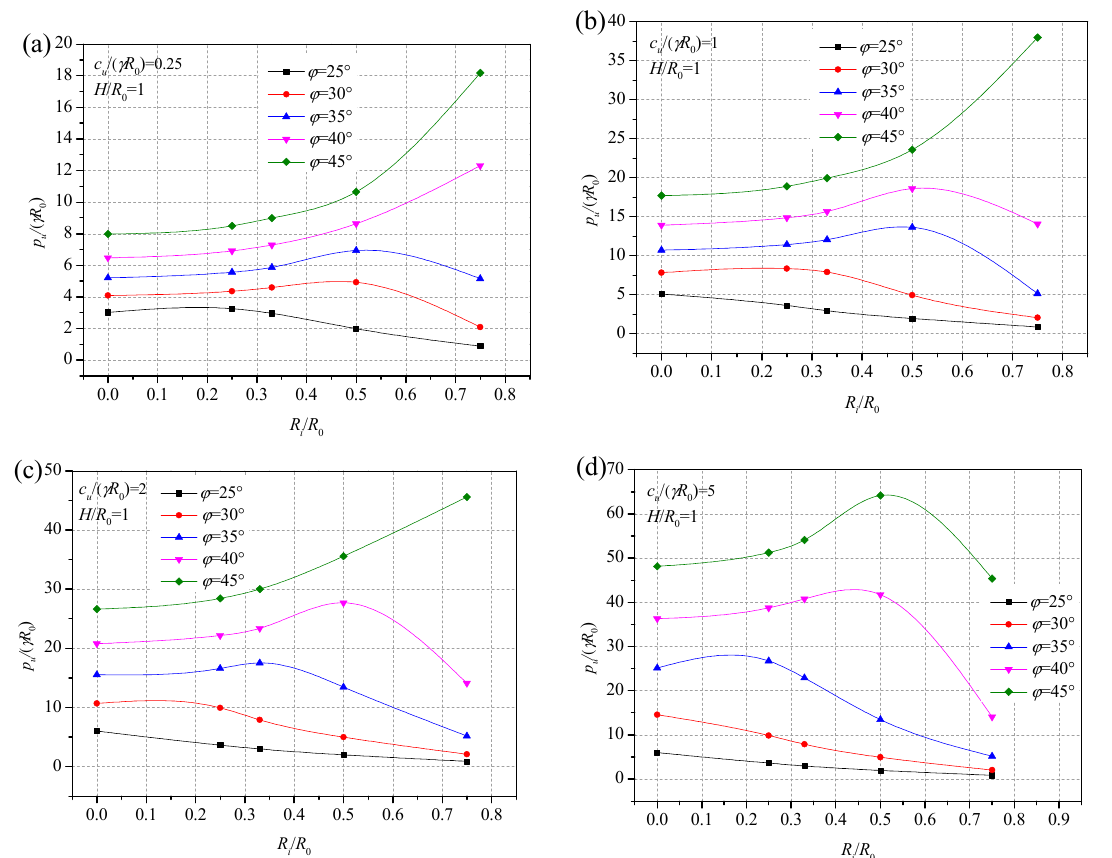
Figure 5. Variation in the normalized bearing capacity, p / ( γ R 0 ), with R i / R 0 and ϕ for H / R 0 = 1 with ( a ) c u / ( γ R 0 ) = 0.25, ( b ) c u / ( γ R 0 ) = 1, ( c ) c u / ( γ R 0 ) = 2, and ( d ) c u / ( γ R 0 ) = 5.